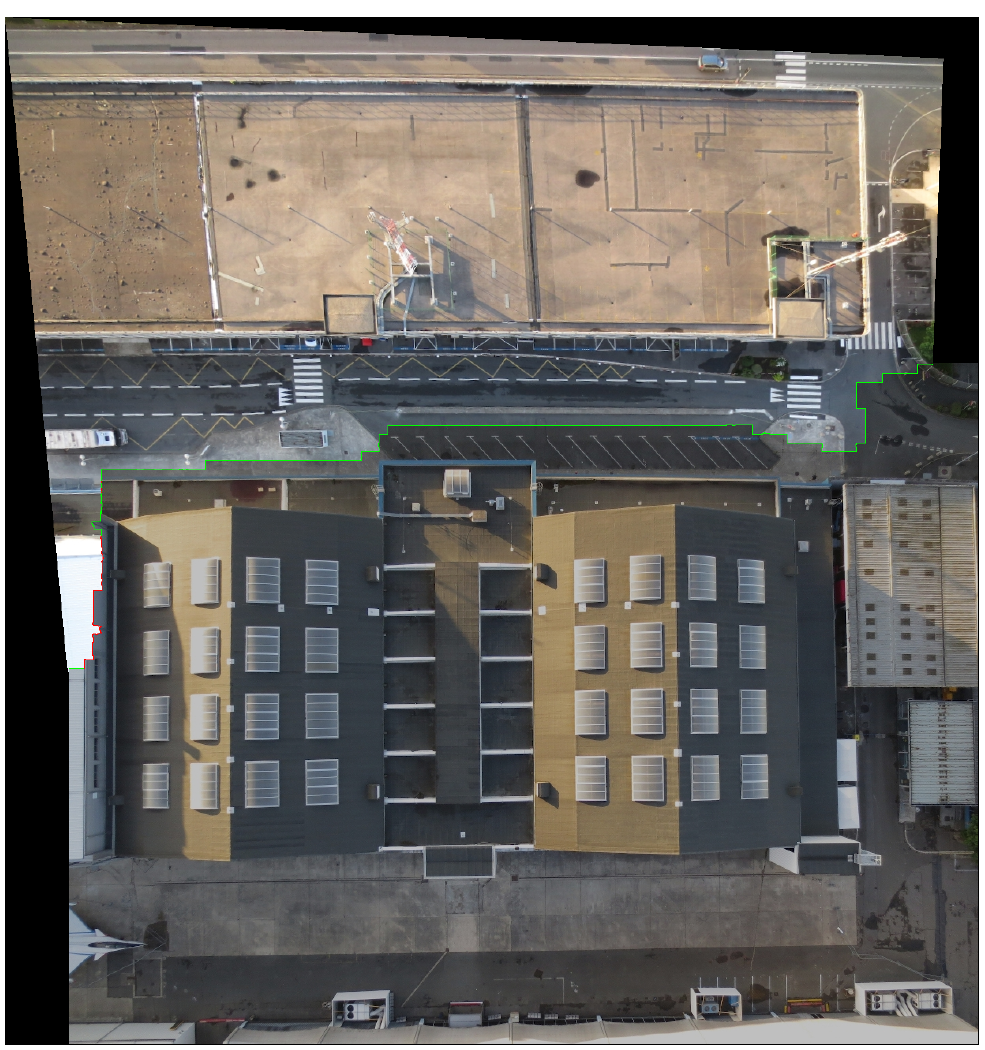
Figure 5. The partition result of Figure 1b, where the aligned color difference pixels are marked in green color and the misaligned color difference pixels are marked in red